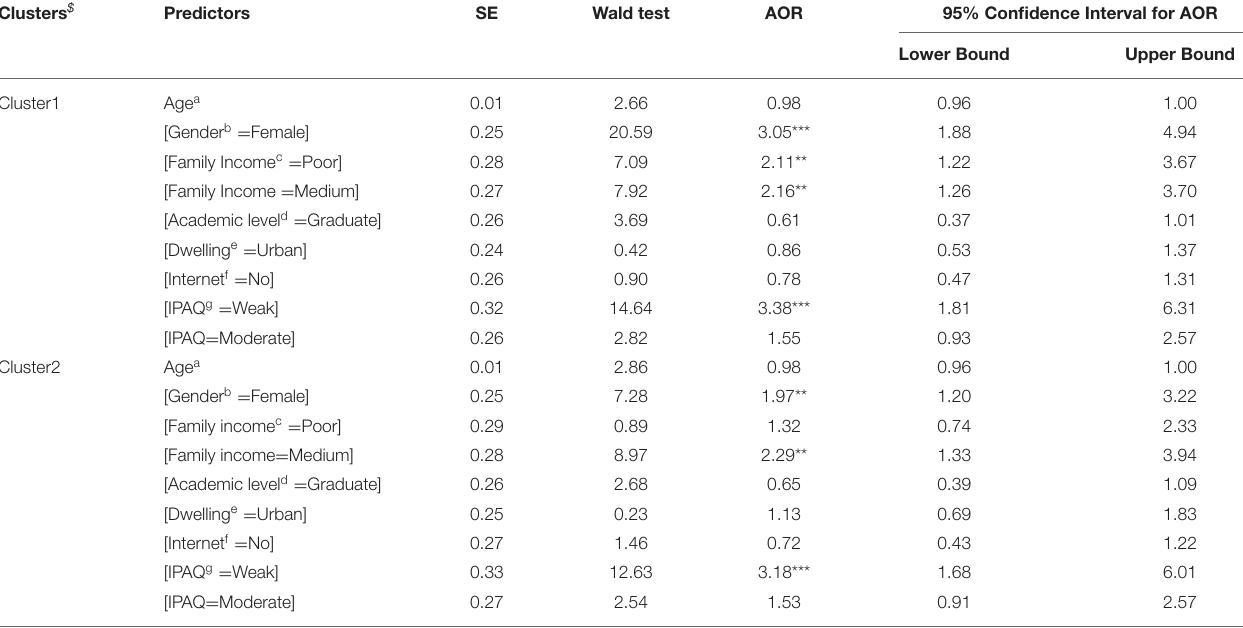
TABLE 3 | Multinomial logistic regression for the positive mental health profiles. Clusters